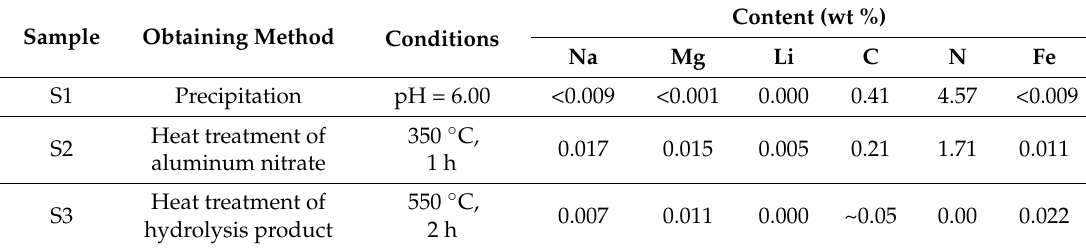
Table 1. Impurity content of samples